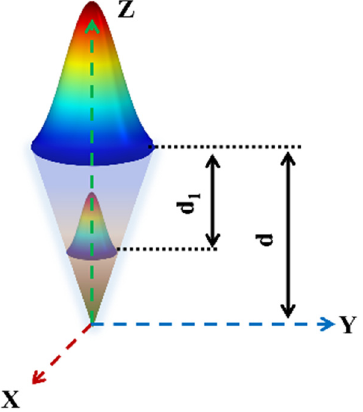
Figure 3: Heat source model of cone heat source